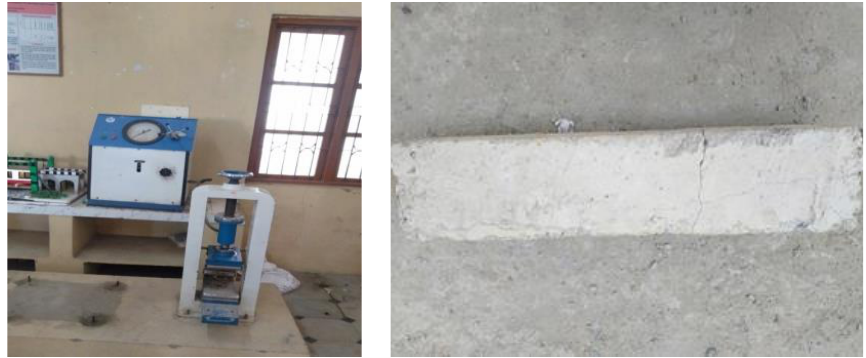
Figure 2. Flexural strength test.